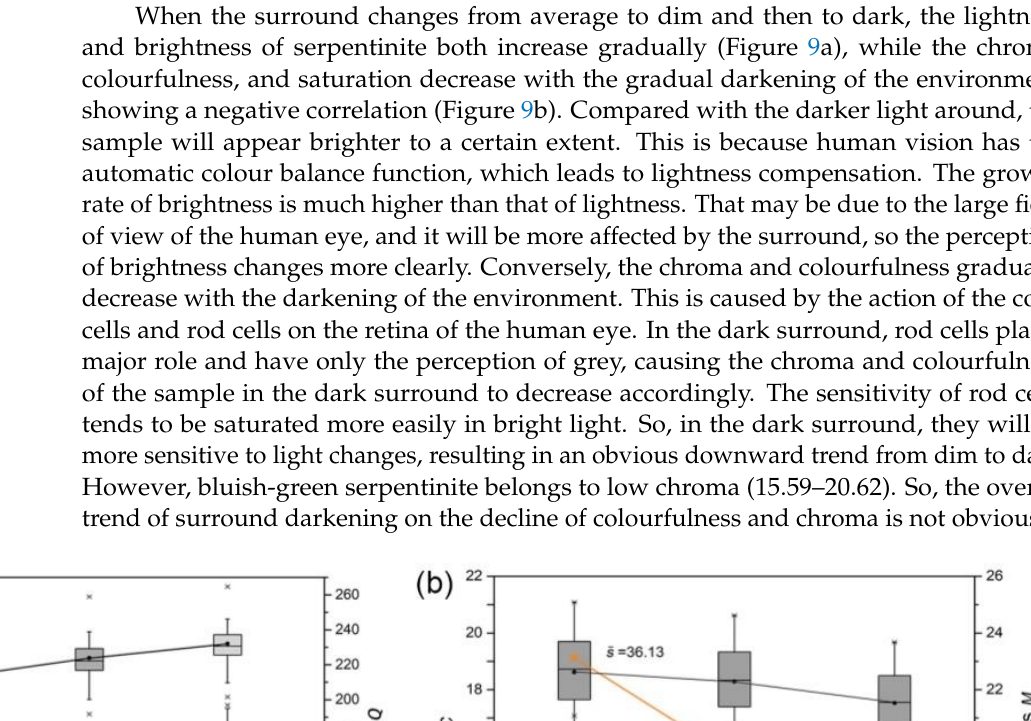
10 of 15 Figure 8. Chromaticity values of serpentinite samples under different light sources based on CIE1976 L*a*b* measured by the computer vision system. 4. Discussion 4.1. Influence of Surround Change on Colour Appearance When the surround changes from average to dim and then to dark, the lightness